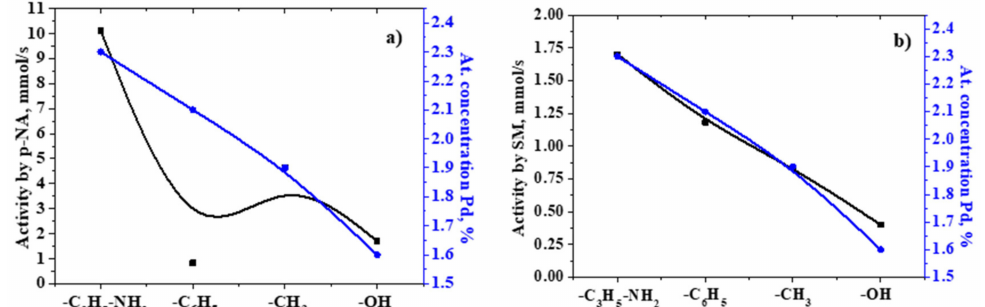
Figure 14. Dependences of the catalysts activity in the hydrogenation of 4-nitroaniline ( a ), sodium maleate ( b ), and the surface content of metallic palladium on nature of functional groups on the support surface.